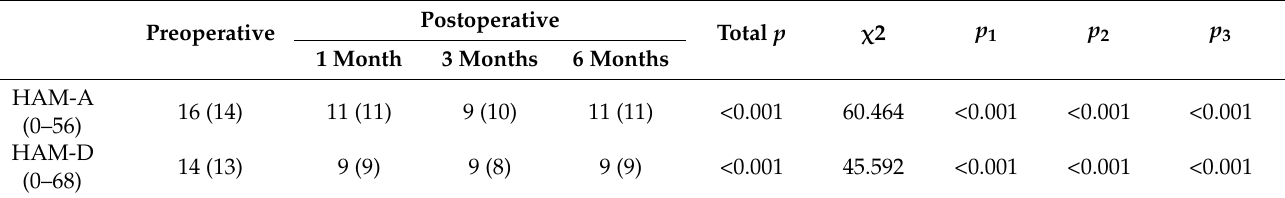
Table 1. HAM-A and HAM-D scores after STN-DBS [M